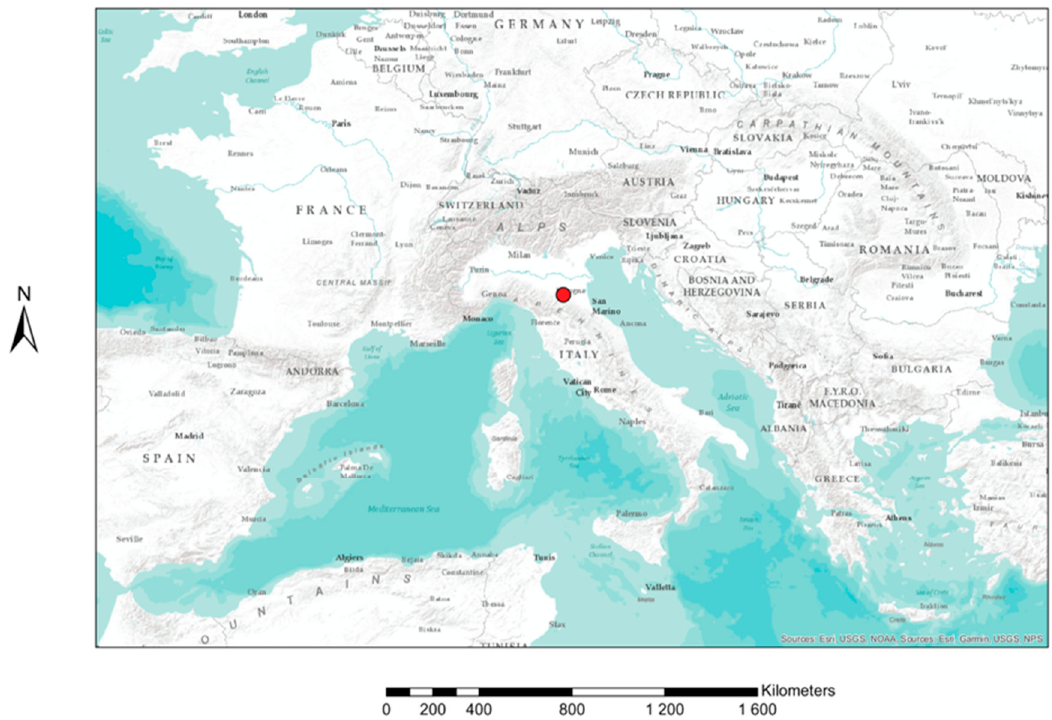
Figure 1. Map showing the location of the city of Bologna in Italy (red dot) (source: Esri, Garmin, USGS -United States Geological Survey-, NPS-National Park Service-).